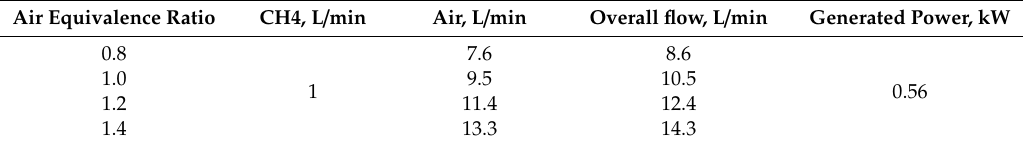
Table 1. Inlet parameters for fuel and air flows at di ff erent air equivalence